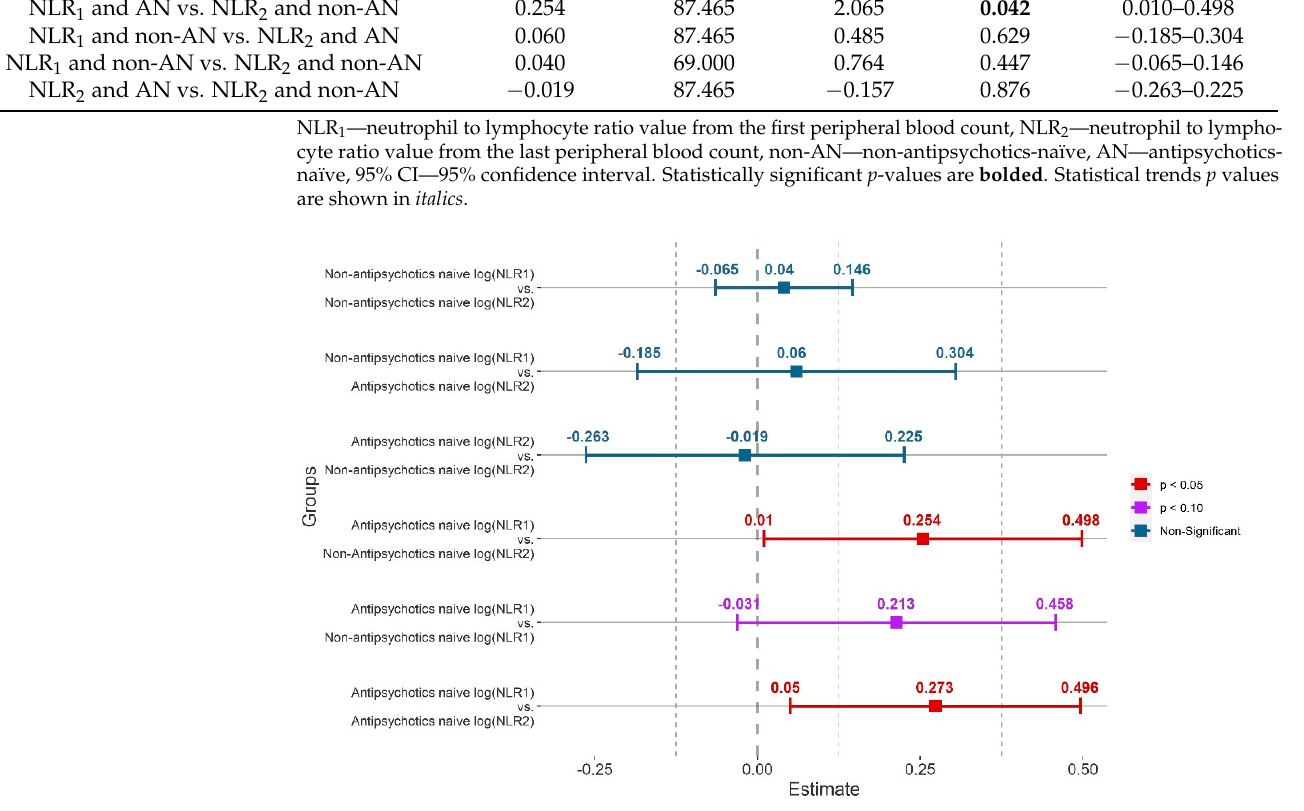
Figure 3. Summary of post-hoc test results for the final model for log (NLR x ). NLR 1 —neutrophil to lymphocyte ratio value from the first peripheral blood count. NLR 2 —neutrophil to lymphocyte ratio value from the last peripheral blood count. 95% confidence intervals and marginal means have been marked. Red indicates a statistically significant result, violet indicates a statistical trend, and blue indicates statistically insignificant p values.